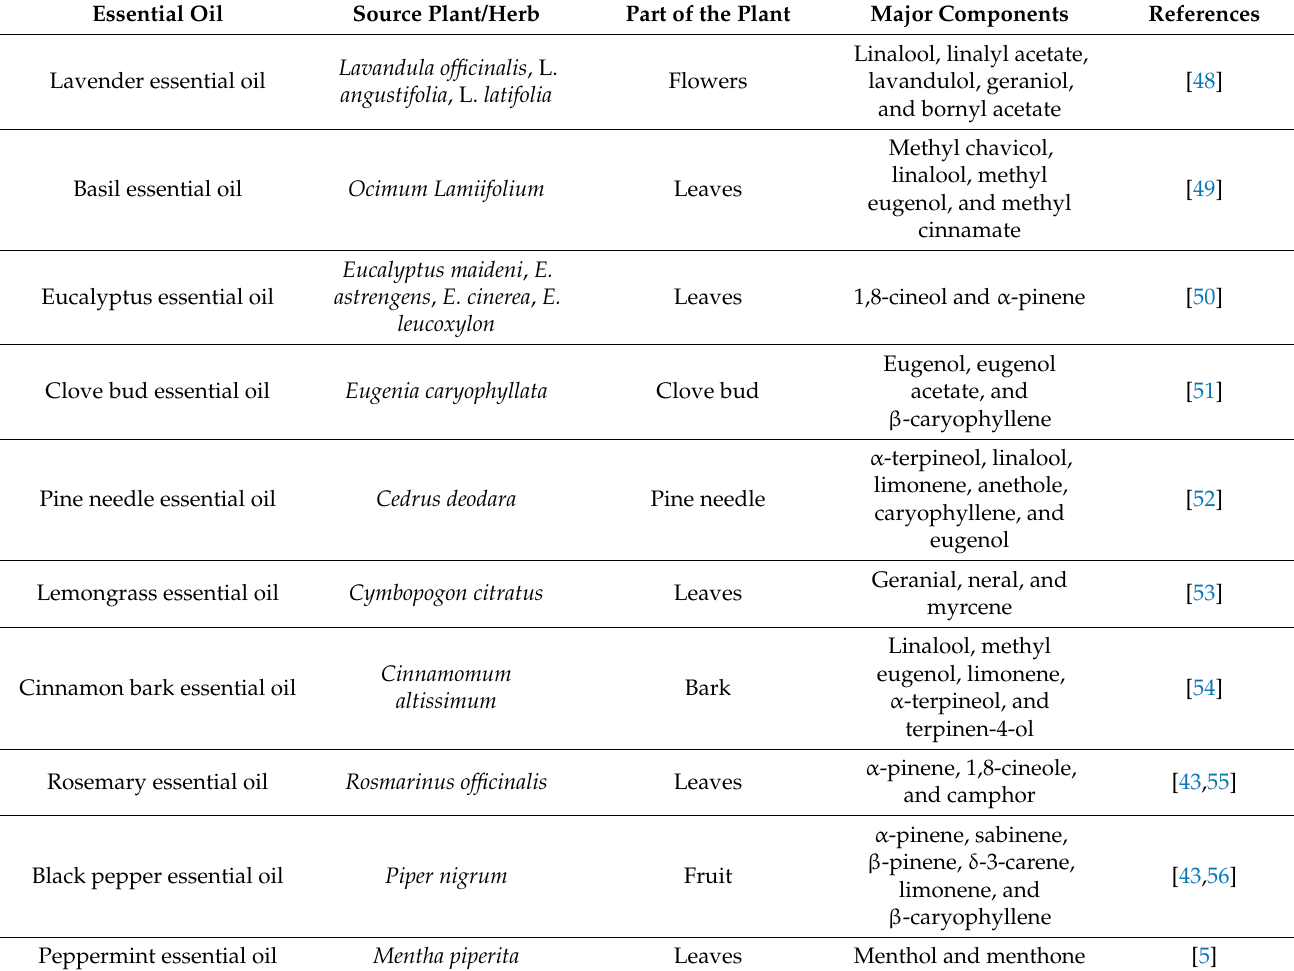
Table 1. Source and major components of some of the common essential oils